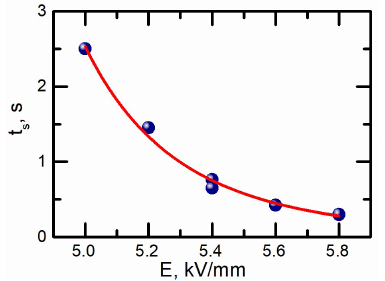
Figure 10. The field dependence of the switching time measured during the polarization reversal with artificial dielectric layer. The experimental data was fitted by Equation (1).